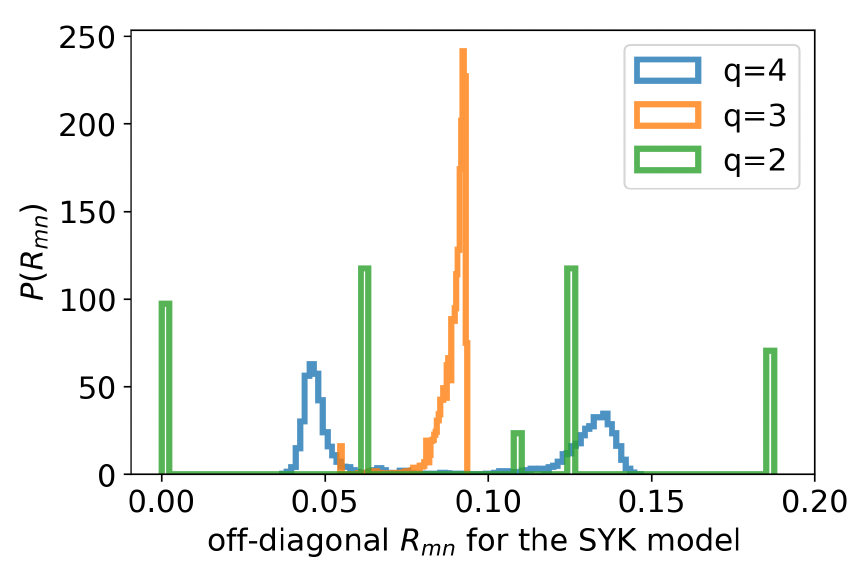
Figure 18 . The distribution of off-diagonal R mn for the q = 2 , 3 , 4 SYK model with N = 14 . The degree of locality is controlled at k = 4 . Notice that the q = 3 case has a small spike at less than the majority of the off-diagonal values. The spike comes from a more suppressed anti-diagonal